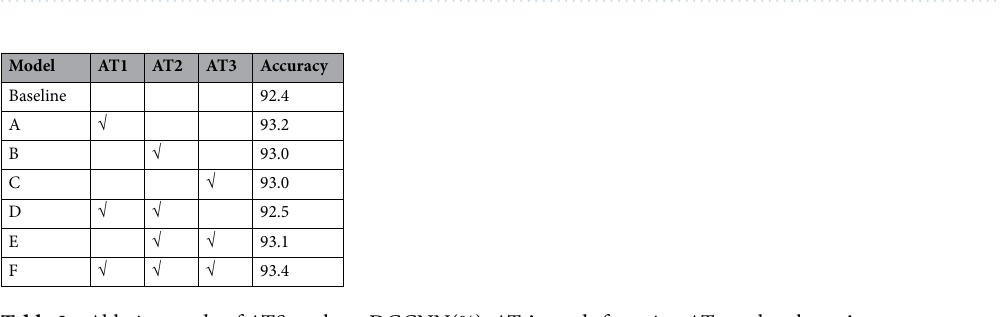
Figure 5. The sensitivity of k used in K-Nearest Neighbor algorithm (k = 5, 10, 20, 30).